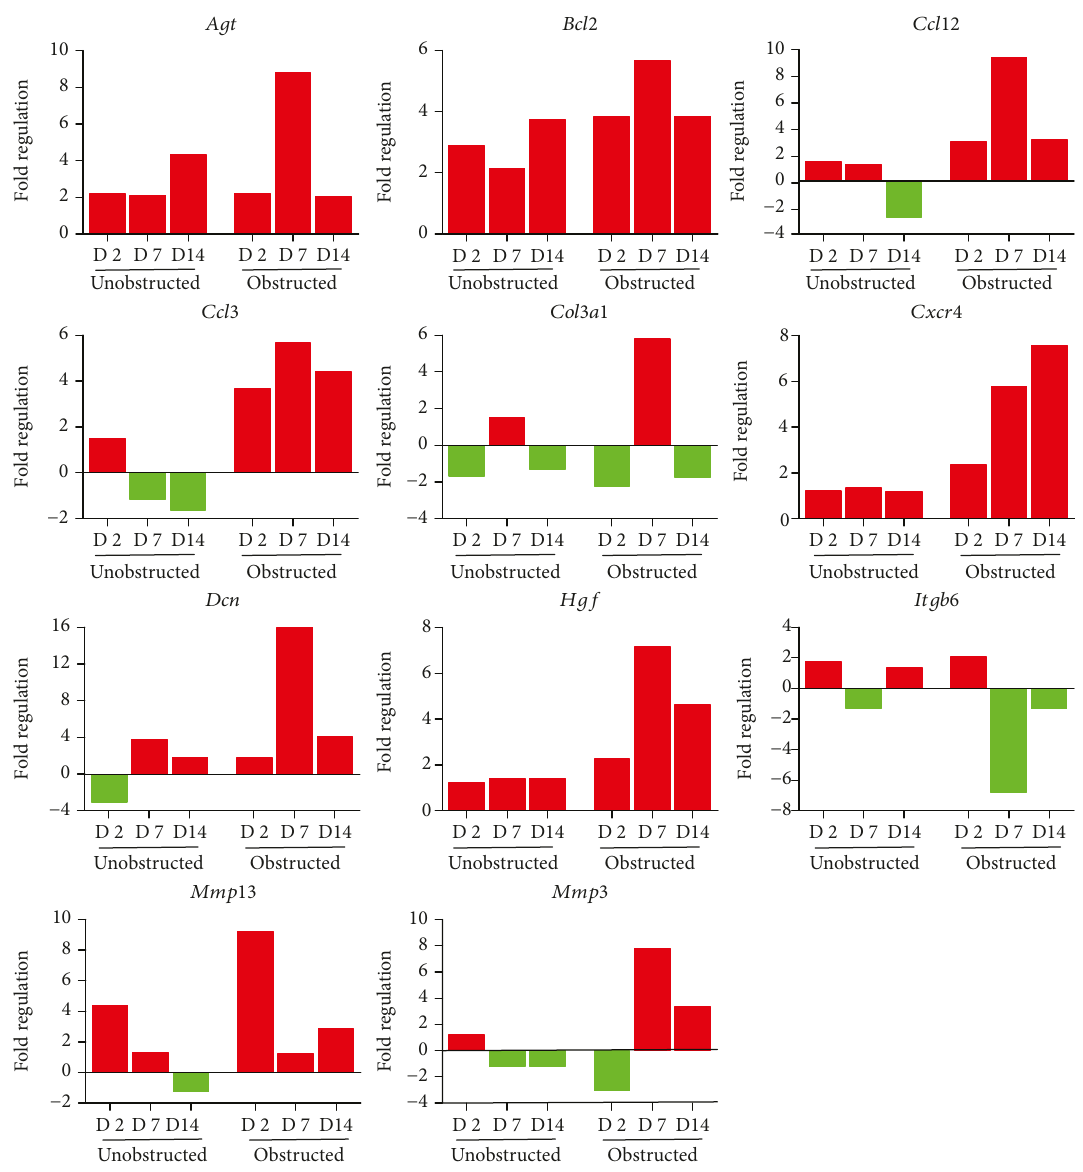
Figure 7: The fold changes of expression of representative genes. Data shows the representative genes that up- and downregulated over 5 folds in the renal tissues at any time point after unilateral ureteral